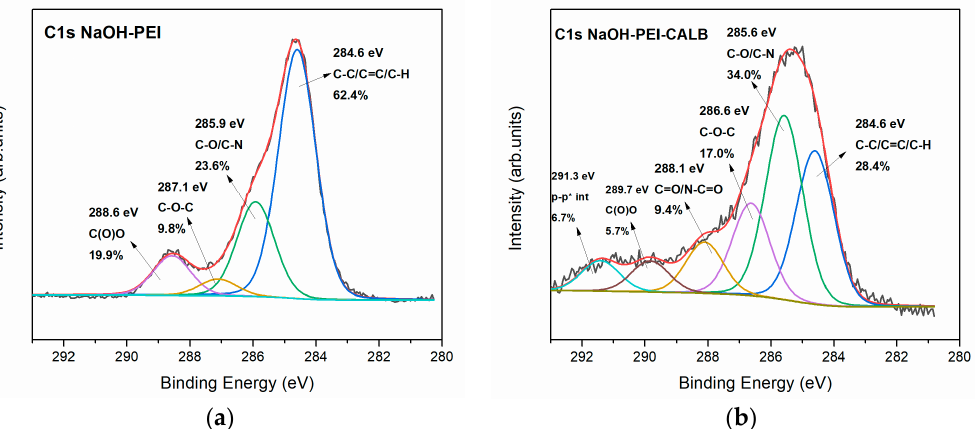
Figure 2. C1s photoelectron spectra for the modified 3D ‐ printed PLA structures ( a ) before enzyme immobilization, ( b ) after enzyme immobilization.